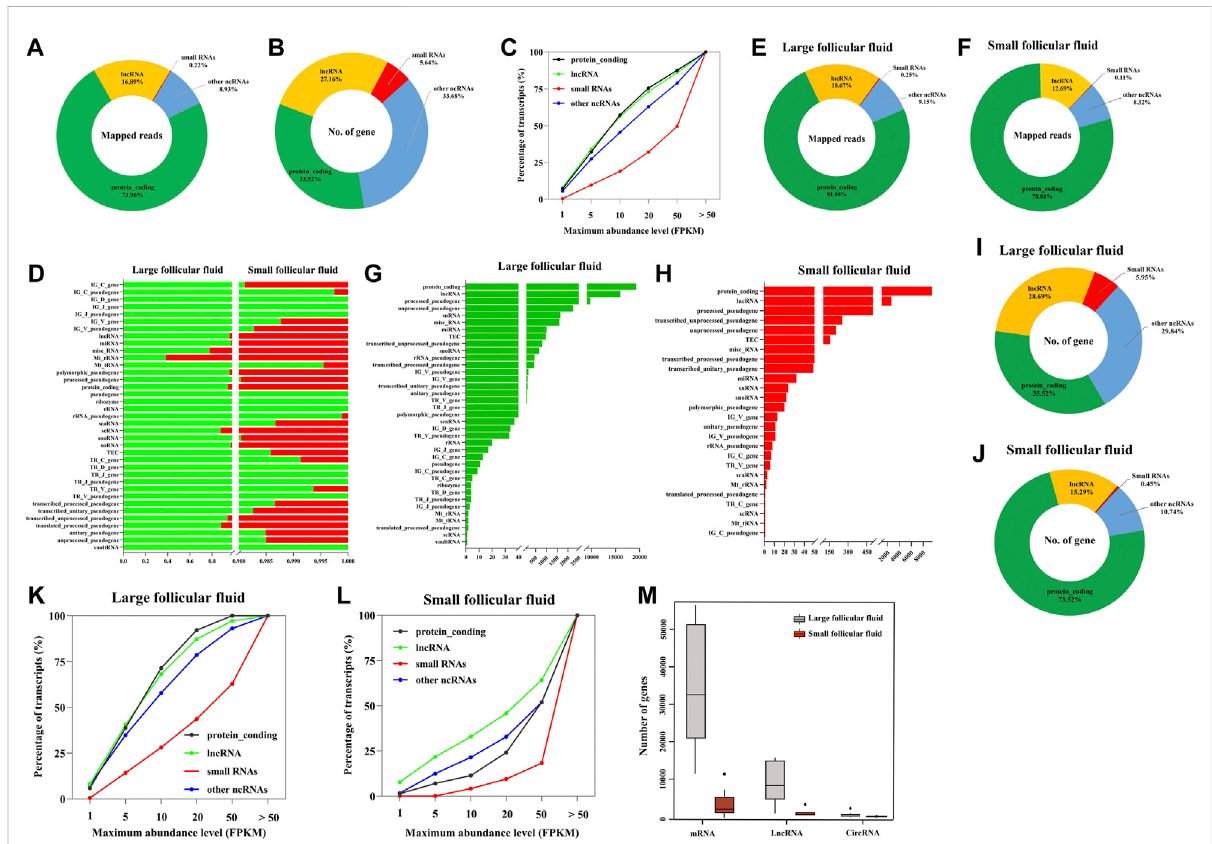
FIGURE 3 Biotype analysis of RNA was identi fi ed in follicular fl uid. (A) Proportions mapped reads to various types of RNA. (B) Distribution of genes in follicular fl uid. (C) RNAs are plotted as the percentage of quanti fi ed transcripts against the expression level in follicular fl uid. (D) Percentage of total aligned reads for RNA in follicular fl uid by Ensembl biotypes. Numerical values for each biotype are found in Supplementary Table S3. (E) and (F) Distribution of mapped reads to the annotated genes in large follicular fl uid and small follicular fl uid samples, respectively. (G) and (H) Distribution of genes in large follicular fl uid and small follicular fl uid samples by Ensembl biotypes, respectively; (I) and (J) Distribution of genes in large follicular fl uidand small follicular fl uid samples, respectively. (K) and (L) RNAs are plotted as thepercentage ofquanti fi edtranscripts againstthe expression level inlarge follicular fl uidand smallfollicular fl uidsamples, respectively. (M) Distribution of RNAs persampleamong large follicular fl uid (n = 16) and small follicular fl uid (n =